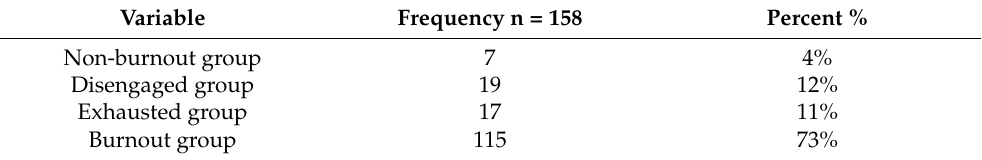
Table 1. Division participants in groups, depending on the mean scores derived from the OLBI test. Variable Frequency n = 158 Percent % Non-burnout group Disengaged group Exhausted group Burnout group 115